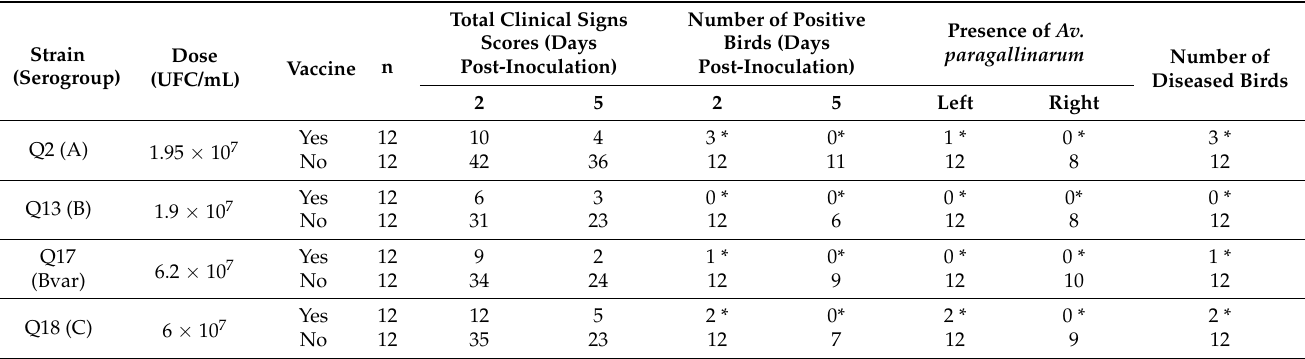
Table 2. Trial 4. Protection. Chickens were vaccinated subcutaneously on weeks 5 and 8 of life. Three weeks later, all birds were inoculated into the left infra-orbital sinus with 0.2 mL of each strain. Clinical signs score for all birds were observed on days 2 and 5 post-inoculation. The birds were scored individually between 0 and 4 points for each facial side [58]. A bird was considered positive if it scored at least 2 points in one infra-orbital sinus. On day 5 post-inoculation, all birds were euthanized and both infra-orbital sinuses were cultured for the presence of Avibacterium paragallinarum . A bird was considered diseased if it scored at least 2 points on one of both days of observations for clinical signs or if Av. paragallinarum was re-isolated from one or two infra-orbital sinuses.